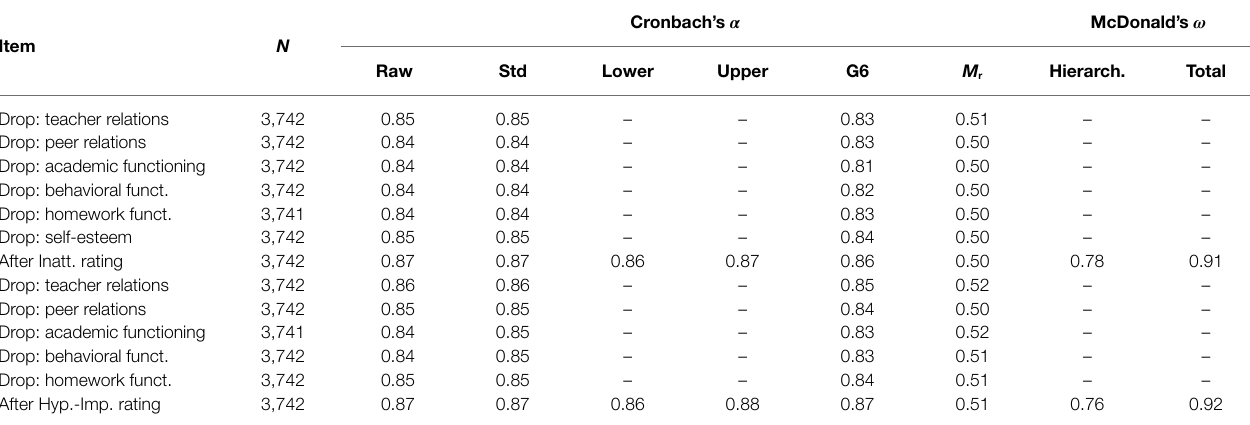
TABLE 2 | Reliability for the impairment items and item drop of the ADHD Rating